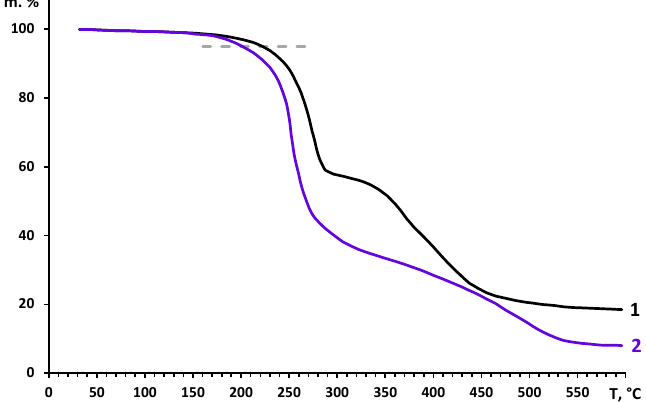
Figure 8. TGA curves for films of initial PMP (1) and quaternized sample 6 Figure 8 . TGA curves for films of initial PMP (1) and quaternized sample 6 (2).